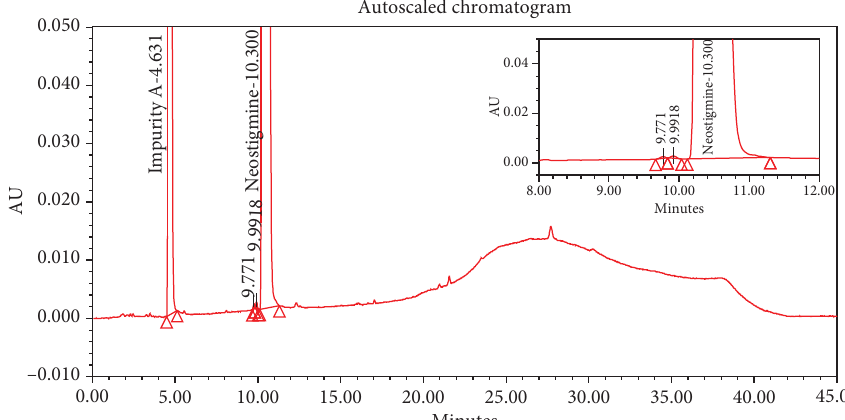
Figure 8: Chromatogram of alkali hydrolysis of neostigmine methylsulfate API (5mL of 0.1N NaOH at 60 ° C and for 30min).